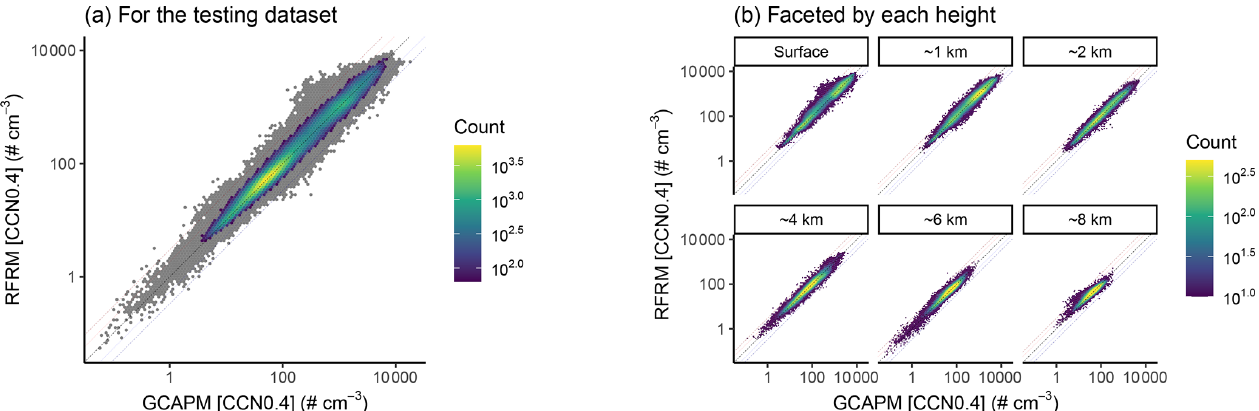
Figure 8. Binned scatterplot of RFRM versus GCAPM simulated [CCN0.4]. Color bar shows the counts of points in each hexagonal bin. Bins with low counts ( < 1% of maximum count: ≈ 3% of the data) are shaded gray. The lines indicate MFB of 0 (black; perfect agreement), + 1 (darker red), − 1 (darker blue), + 0 . 6 (lighter red), and − 0 . 6 (lighter blue).